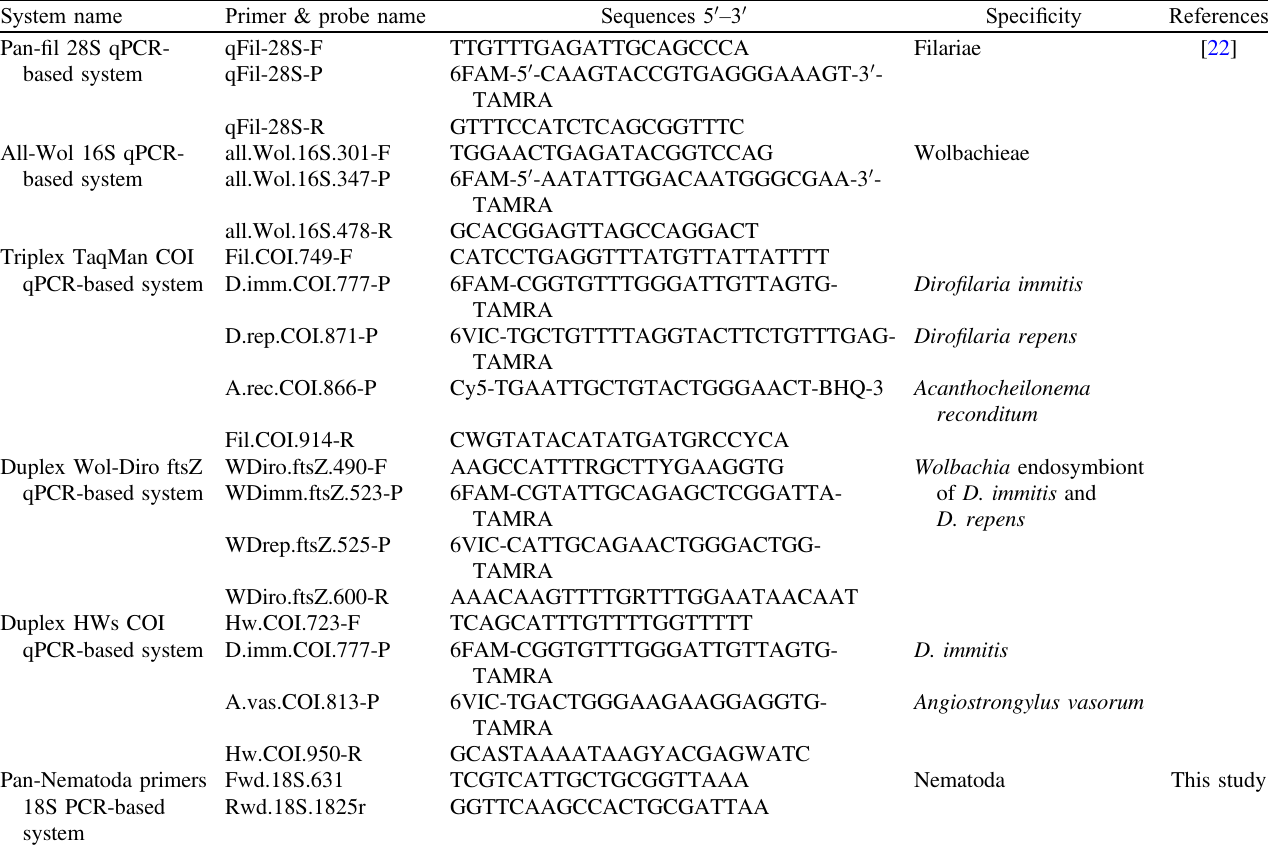
Table 1. Primers and probes used in this